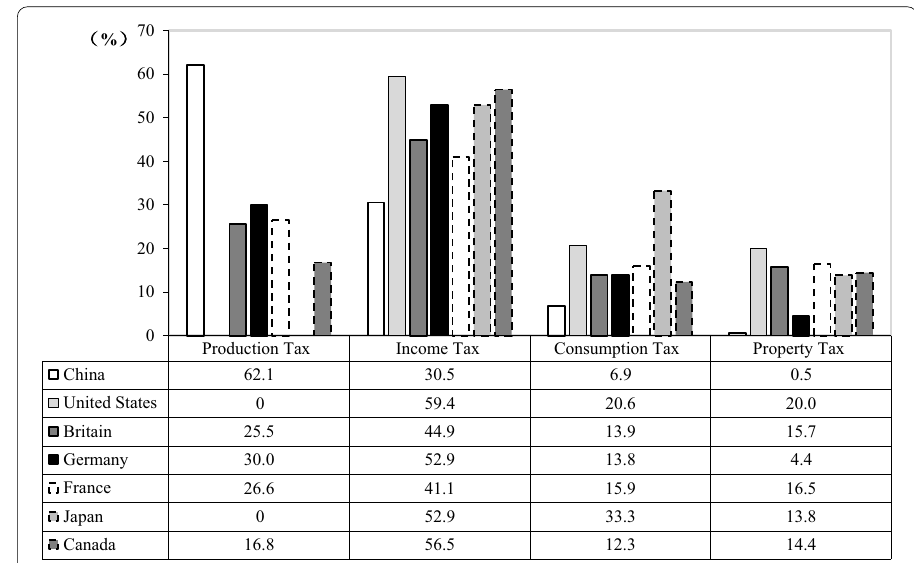
Fig. 5 Comparison of taxation system between china and typical OECD countries, 2017. Data source: CEInet Statistics Database and